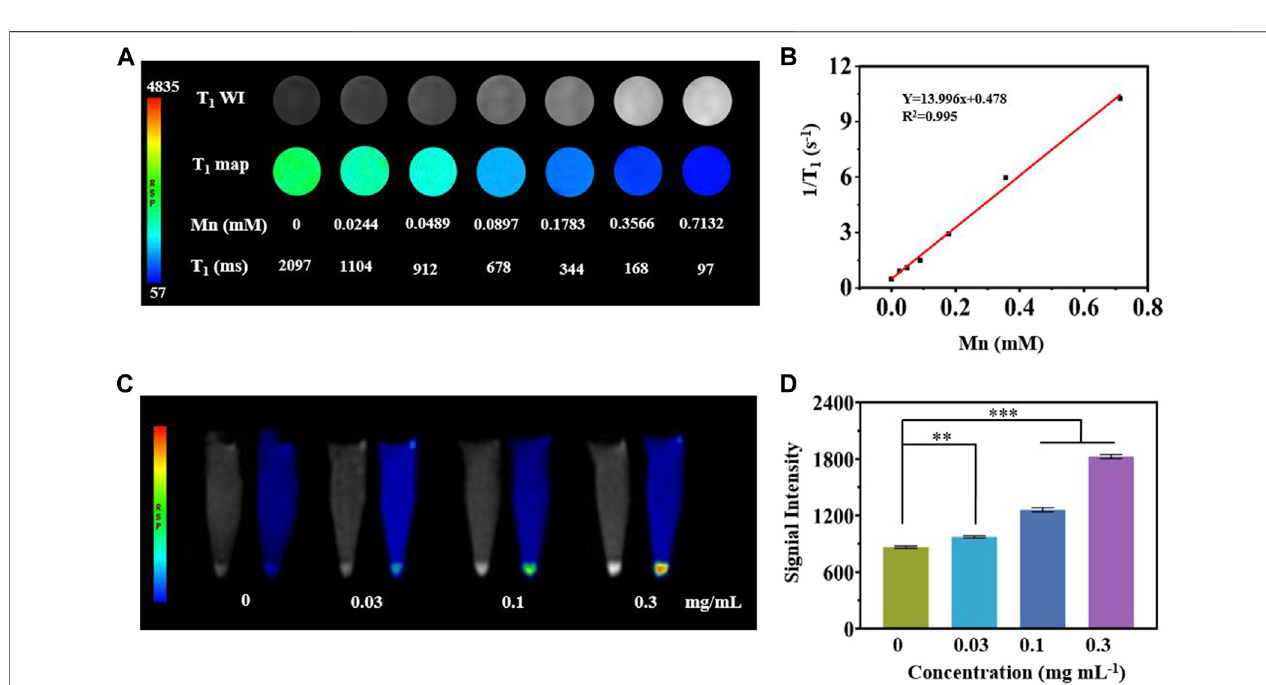
FIGURE 5 | In vitro MRI studies ofMCPM NPs. (A) T 1 -weighted phantom images and pseudo-color images of MCPM NPs at different Mn concentrations. (B) The longitudinal relaxation rate of MCPM NPs serves as an index for a series of Mn concentrations. (C) T 1 -weighted MRI images of MCPM NPs for MDA-MB-231 cells at a cascade of Mn concentrations. (D) Pro fi les of T 1 MRI signals of the MDA-MB-231 cells in (C) . ** p < 0.01, *** p < 0.001.